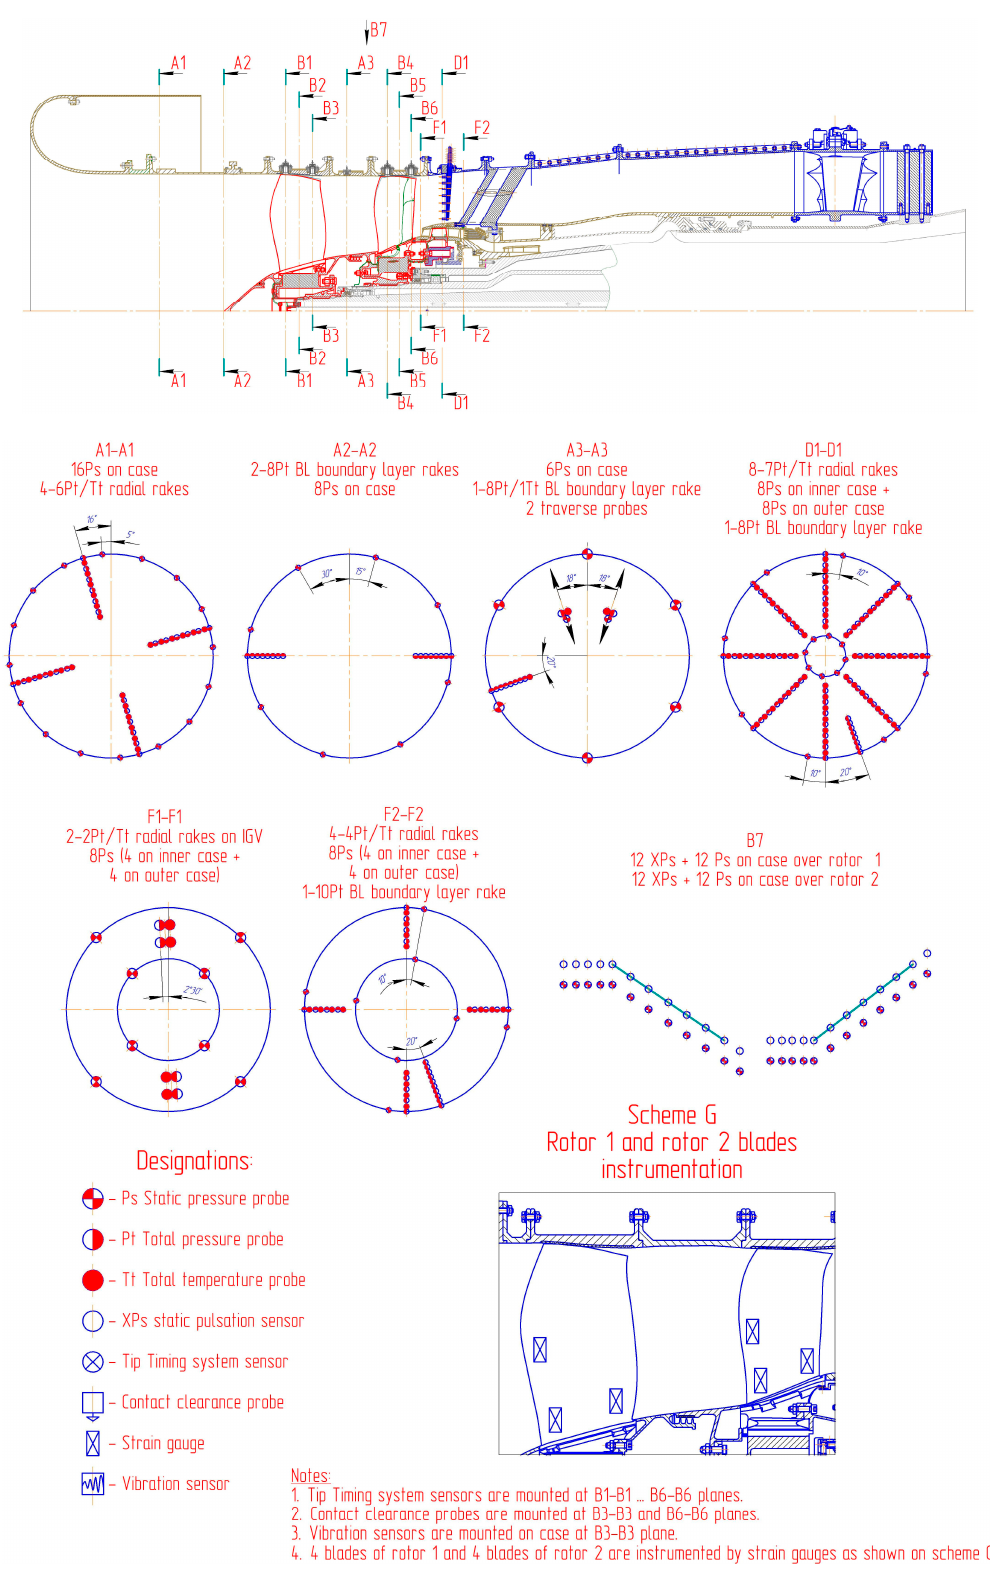
Figure 9. Counter rotating ducted CRTF1 fan model instrumentation scheme.